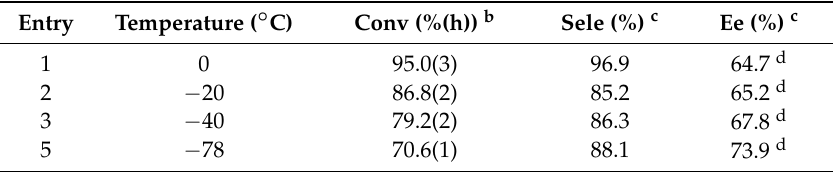
Table 4. The results of asymmetric epoxidation of styrene in different temperatures over catalyst 3 a .